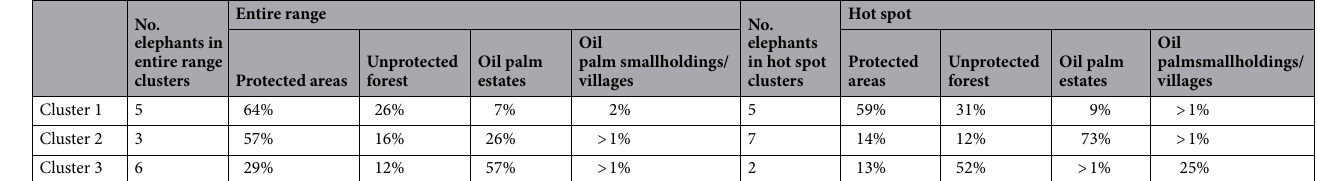
Table 6. Number of elephants and proportions (%) of average time spent per cluster (derived from the k-means cluster analyses) for elephant’s entire range and hot